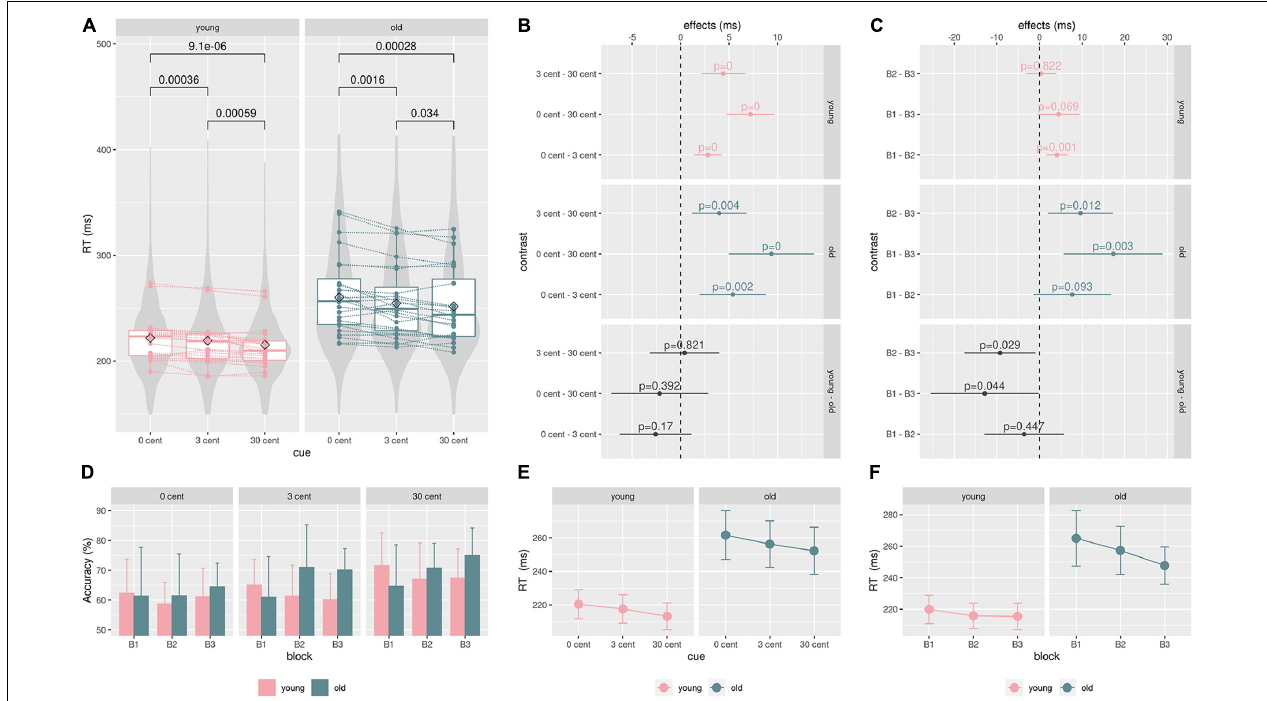
FIGURE 3 | Behavioral data: (A) , Boxplot: single mean reaction time data, lines/points correspond to different participants. P-values from the paired Mann-Whitney U-Test show significant reward-related reaction time speeding within both groups. Violin plots are based on single reaction time data. (B) and (E) , the GEE model results for effects of the groups (young, old) and the cue (0 ct, 3 ct, 30 ct) on reaction times. Reaction time differences between cues did not significantly differ between groups. (D) , a hit rate (accuracy) in percent for each block and condition. Older adults show higher hit rates than younger adults during the second and third blocks across all conditions. (C) and (F) , analyzing the effect of the blocks on reaction times showed that the older adults significantly improved performance from Blocks B1 to B3 and B2 to B3. These improvements are significantly higher in comparison to the younger adults. The younger adults showed only a significant improvement between Blocks B1 and B2, not significantly differing from the older group; color code: green = old, pink = young, gray = contrast.